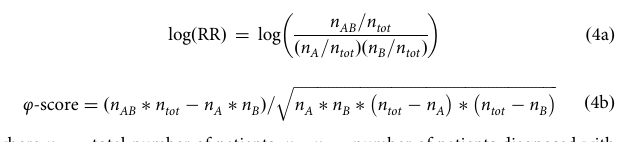
Disease 1: MOA proteins from MEDICASCY or GWAS